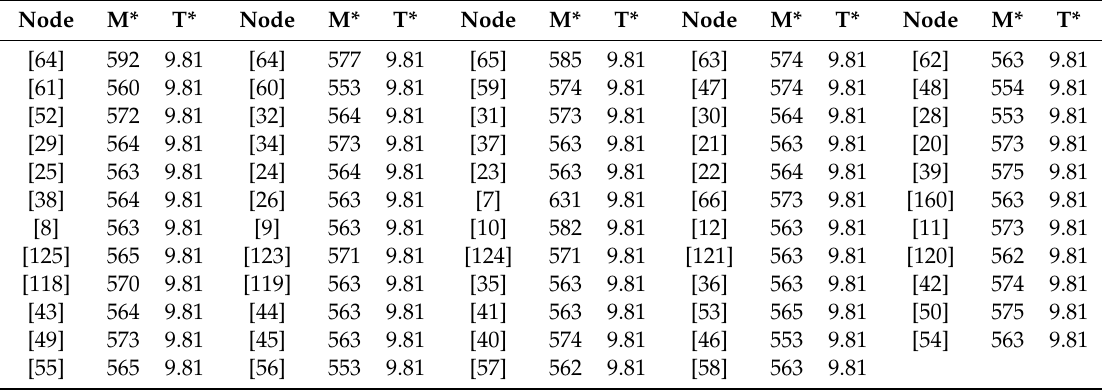
Table 13. The modified optimal maximum inventory level (M*) and optimal common review interval (T*) of all retail stores located in Route 1 based on PRIRPSDRCO 2